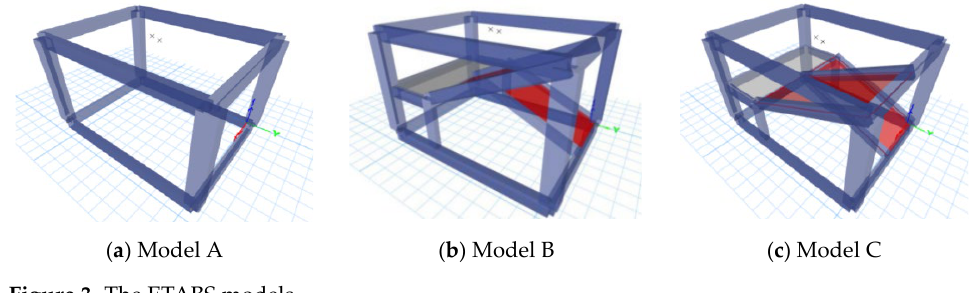
Figure 3. The ETABS models. Figure 3. The ETABS